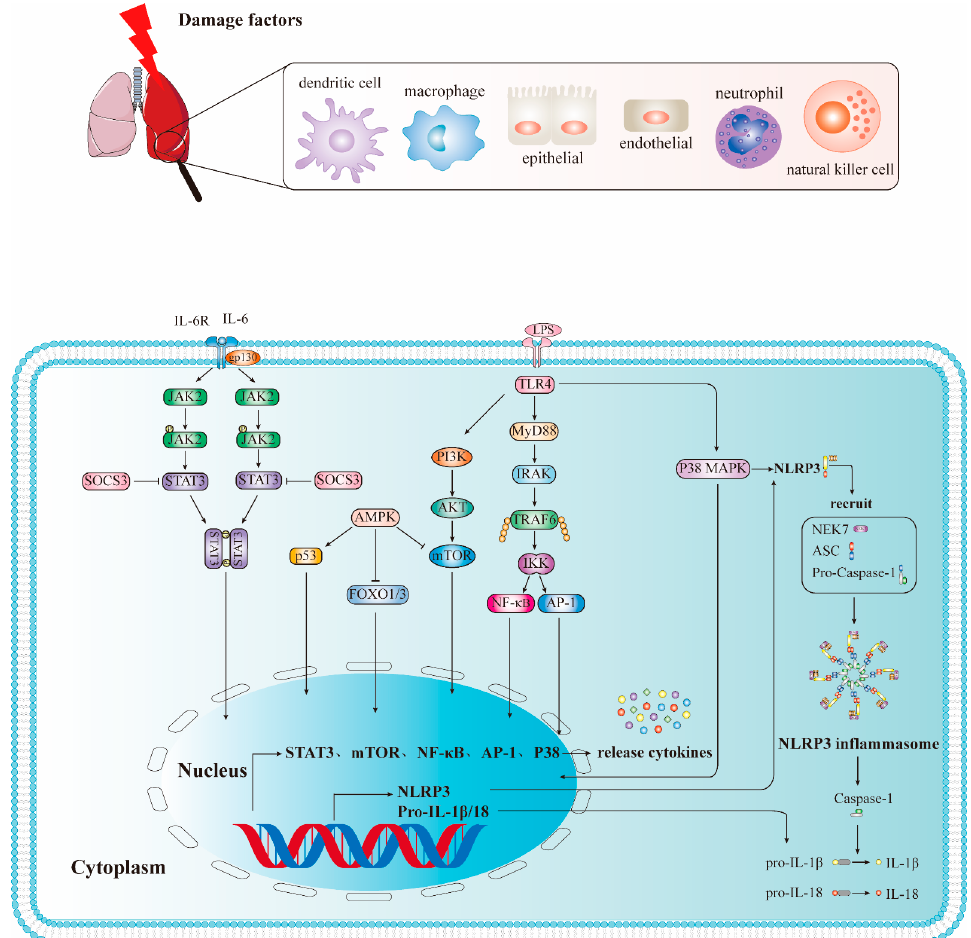
Figure 1. Inflammation-related pathways of ALI/ARDS. DC : dendritic cell; NK : natural killer cell; JAK2 : Janus kinase 2; STAT3 : signal transducer and activator of transcription 3; SCOS3 : Suppressor of Cytokine Signaling 3; PI3K : phosphatidylinositol 3-kinase; AKT : protein kinase B (PKB, also known as AKT); mTOR : Mammalian Target of Rapamycin; TLR4 : Toll-like receptor 4; MyD88 : My- eloid differentiation factor 88; IRAK : interleukin-1 receptor-associated kinase; TRAF6 : tumor necro- sis factor receptor-associated factor 6; IKK : Ikappa B kinase; NF- κ B : nuclear factor kappaB; AP-1 : activator protein-1; NLRP3 : NOD-like receptor thermal protein domain associated protein 3; ASC : apoptosis-associated speck-like protein containing a CARD; Pro-Caspase-1 : pro-cysteinyl aspartate specific proteinase-1; Caspase-1 : cysteinyl aspartate specific proteinase-1.